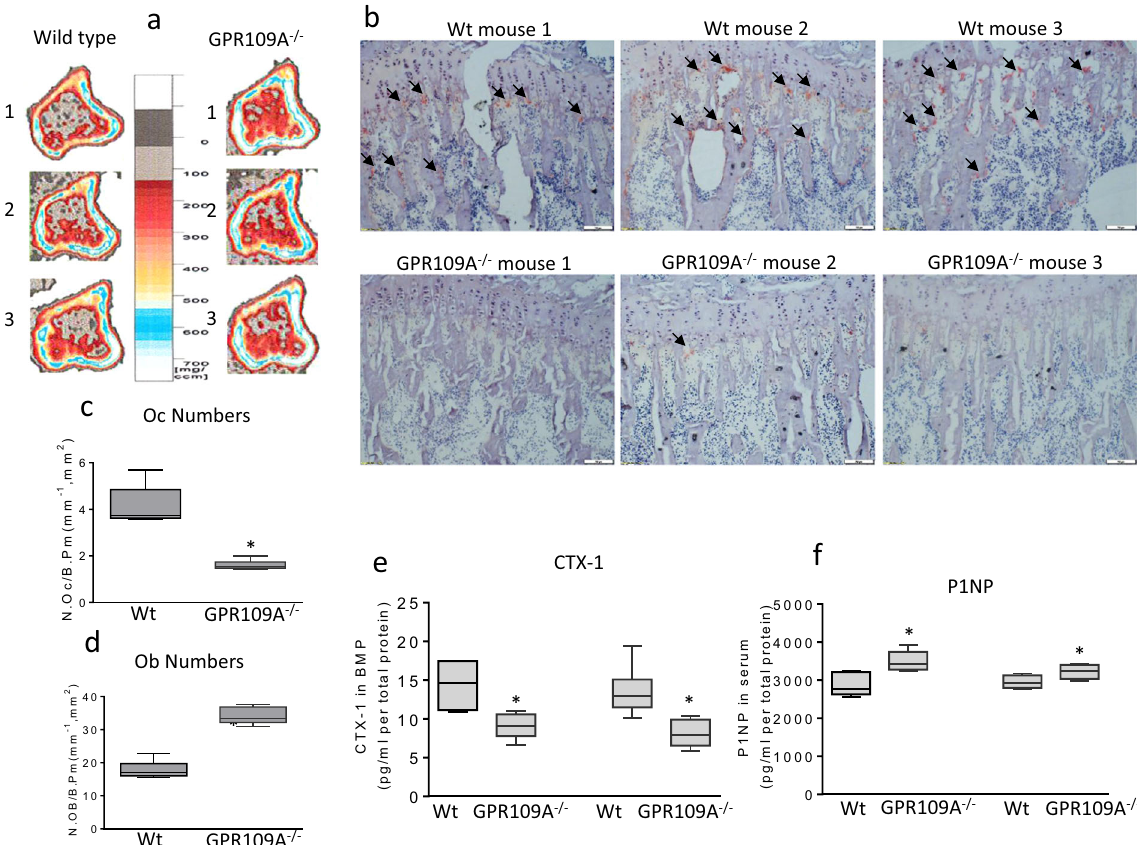
Fig. 4 Increased bone mass in GPR109A − / − mice is associated with decreased osteoclast numbers. a Representative sagittal views of quantitative pQCT analysis of one slice of the proximal tibial from three male samples from each group of mice. Bar in the middle shows color changes from black to white indicating lower to higher bone density. b Bone histology on cryosectioned tibia close to growth plate for TRAPase staining, images of magni fi cation 40x from epi fl uorescent microscope (model BH-2, Olympus) showing three representative male samples from each group. Black arrows show pink TRAPase positively stained osteoclastic cells on bone surface. c Osteoclast and d osteoblast numbers counted per bone from wild type (Wt) and GPR109A − / − mice. e Bone marrow plasma resorption marker CTX-1 and, f serum P1NP levels by ELISA. Left two bars are from male wild type and GPR109A − / − mice and right two bars from age-matched (4-weeks-old) female wild type and GPR109A − / − mice, * p < 0.05 versus respective wild type mice by t -test, n = 6, mean ± SD.